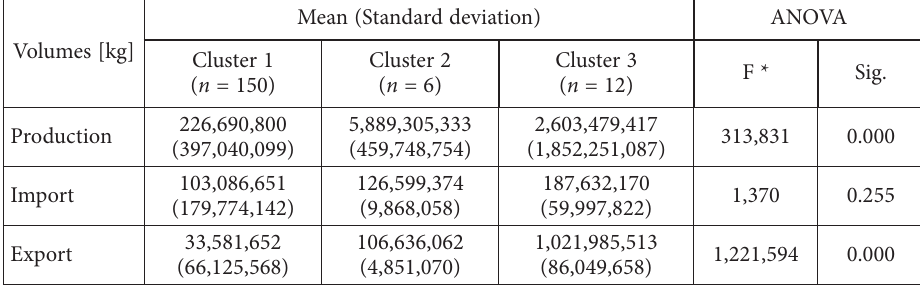
Table 8. Cluster centres and ANOVA for two-stage analysis at the first post-crisis clustering level (source: own elaboration based on COMTRADE,